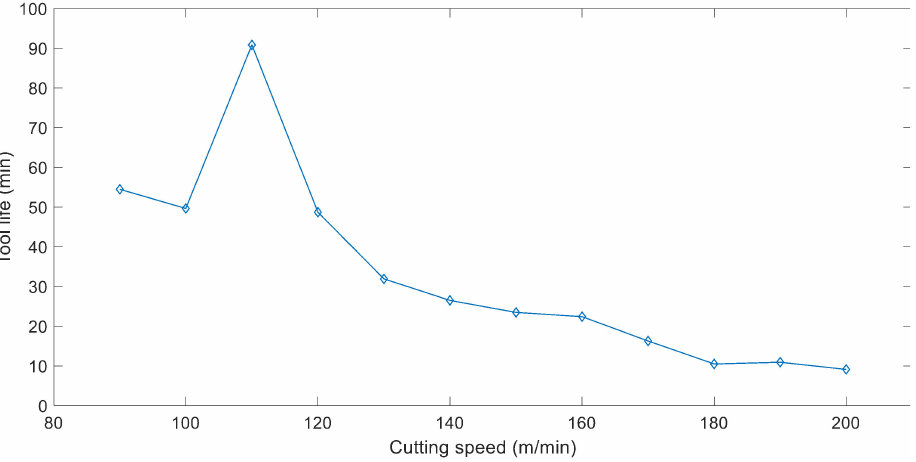
Figure 9. Graph of tool life (min) versus cutting